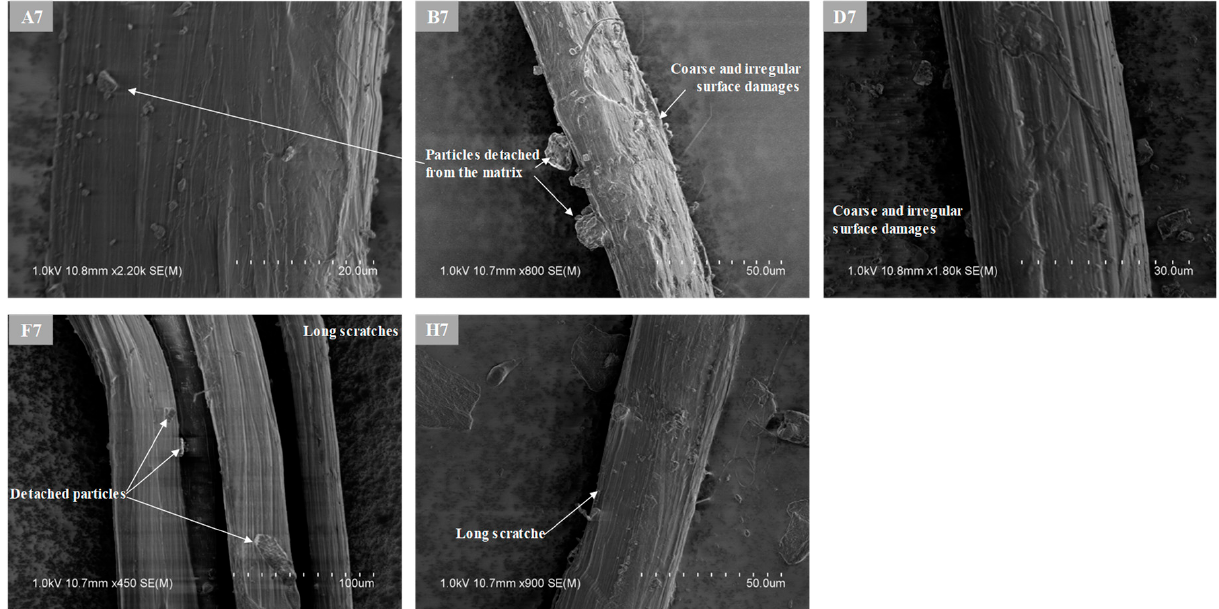
Figure 12. SEM images on polyethylene (PE) fibers pulled out of 7 d cured specimens.